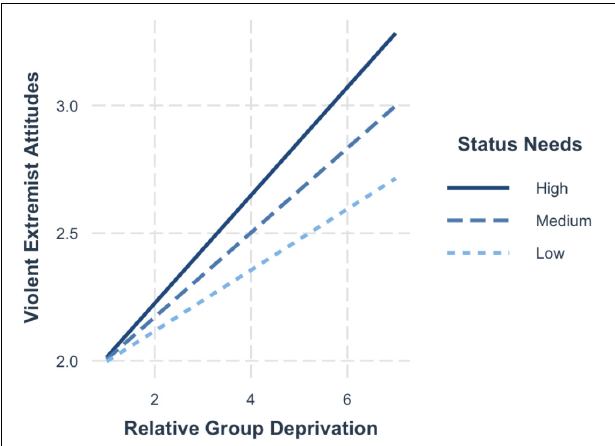
FIGURE 3 | Simple slopes for group deprivation and need for status on violent extremist attitudes.